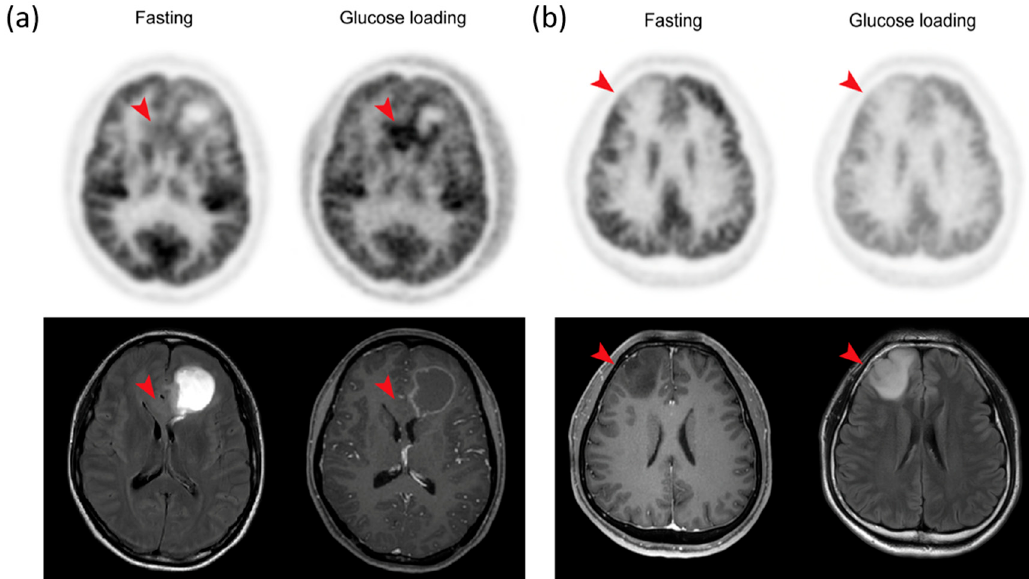
Figure 4. 18 F-FDG PET / CT (upper panel) and FLAIR and T1 enhanced MRI images (bottom panel) after fasting and glucose loading in a patient with ( a ) high-grade and ( b ) low-grade glioma. ( a ) Involvement of glioblastoma was pathologically confirmed in the left frontal lobe and corpus callosum (red arrow) in the glioblastoma. ( b ) Di ff use astrocytoma, IDH-mutant was pathologically confirmed in the right frontal lobe (red arrow).